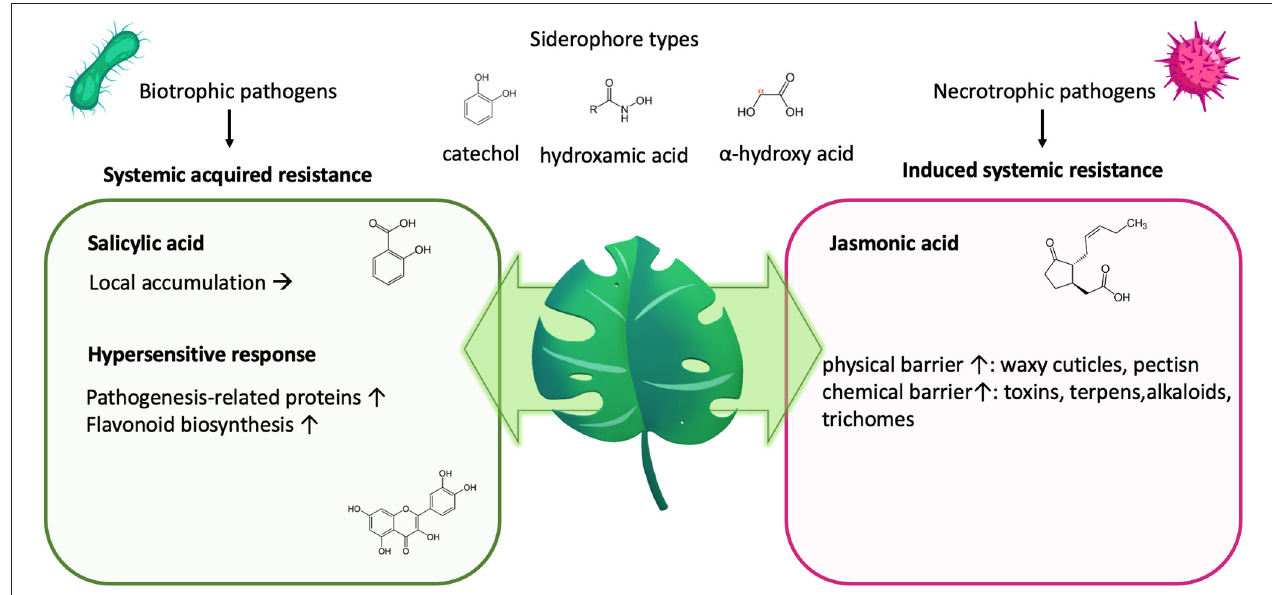
FIGURE 4 | Plant defense and nutrition. Plants will impede biotrophic pathogens, releasing siderophores to sequester iron by initiating a local “hypersensitive response” as part of their “systemic acquired resistance.” This activates the salicylic acid, leading to its accumulation on site and the synthesis of pathogenesis-related proteins and polyphenols/flavonoids. Both can impede nutrient deprivation by the invading pathogen. In contrast, induced systemic resistance counter regulates the systemic-acquired resistance but leads to fortification of the physical and chemical